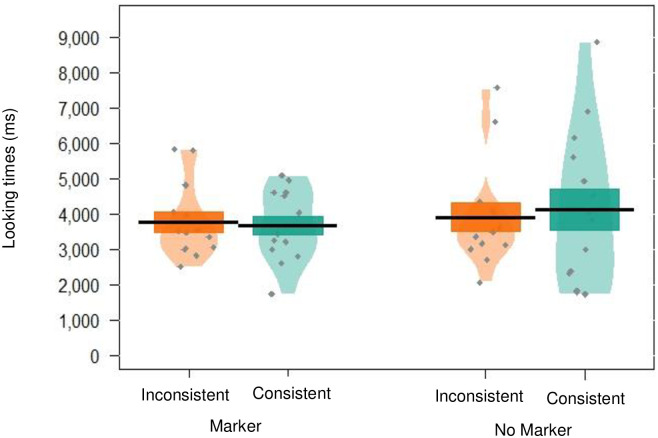
Pirate plot depicting the (raw) mean looking times to trials containing words from the same (consistent) versus different (inconsistent) categories for participants in experiment 1, given for each condition.Black lines indicate the mean, and the coloured blocks indicate SE. The distribution of looking times is given for each group, with individual data points in grey.